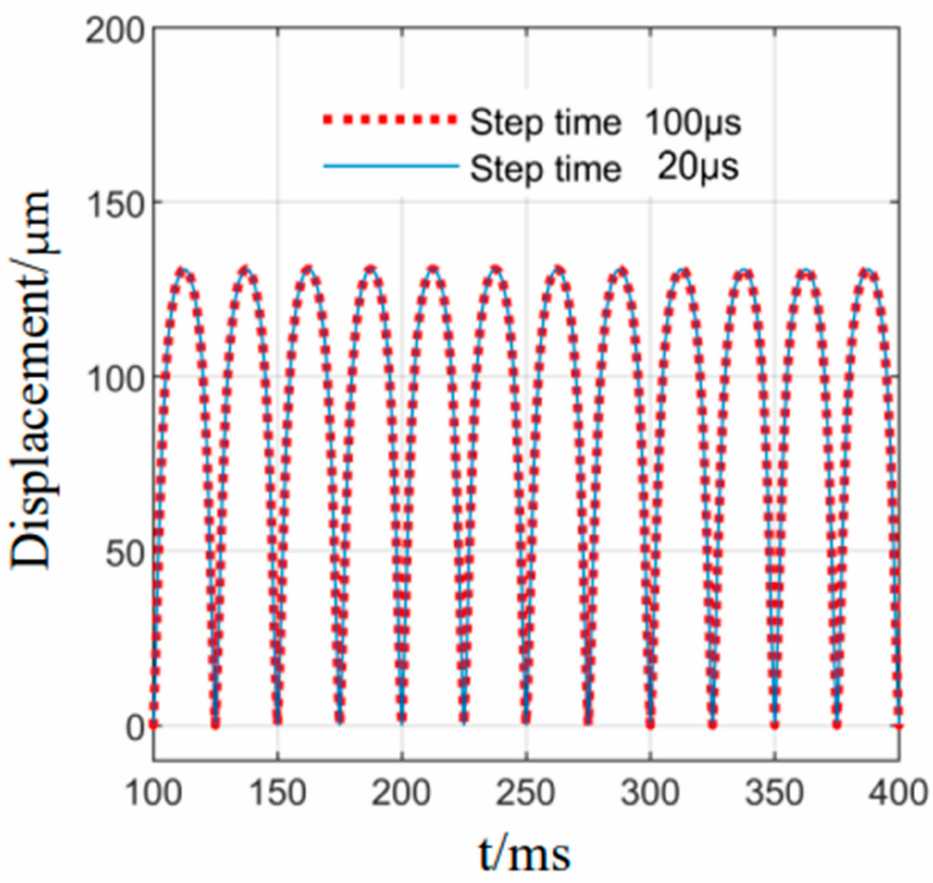
Figure 5. Comparison of output displacement when the step times are 100 µ s and 20 µ